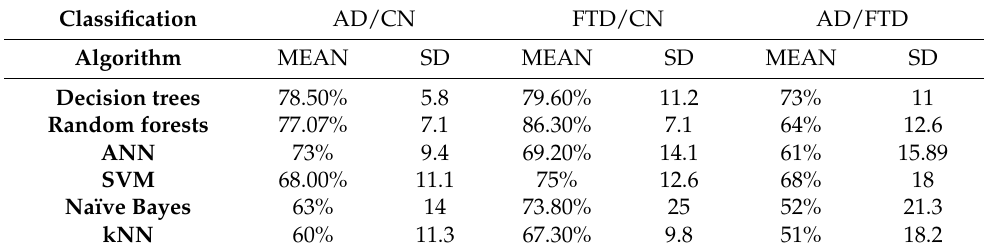
Table 3. Accuracy results of six classification algorithms with leave-one-patient-out cross validation.